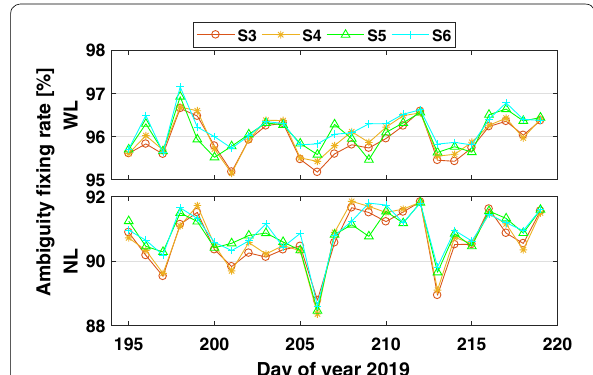
Fig. 14 GPS ambiguity fixing rate